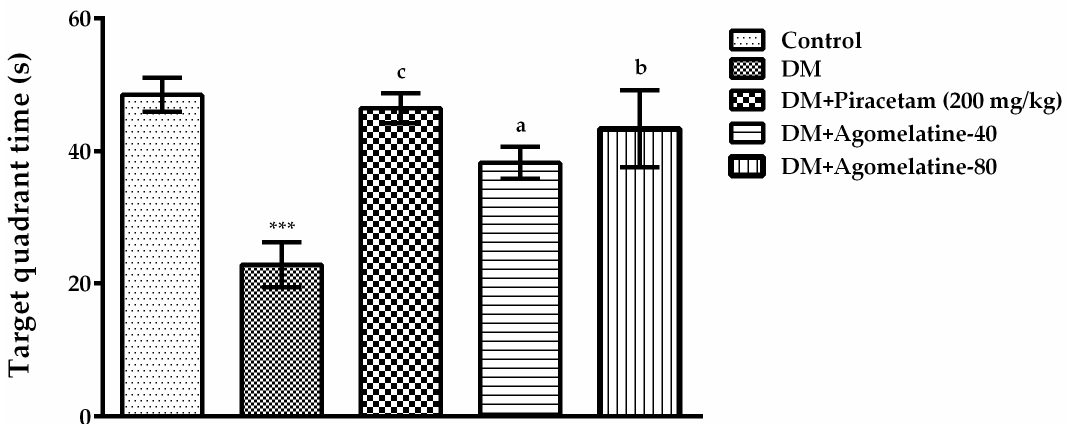
Figure 3. Target quadrant time of normoglycemic rats administered saline solution (control) and diabetic rats administered saline (DM), 200 mg/kg piracetam, 40 mg/kg agomelatine or 80 mg/kg agomelatine for two weeks, in the MWM test. Values are given as mean ± S.E.M. Significant difference against control group *** p < 0.001; Significant difference against DM group a p < 0.05, b p < 0.01, c p <